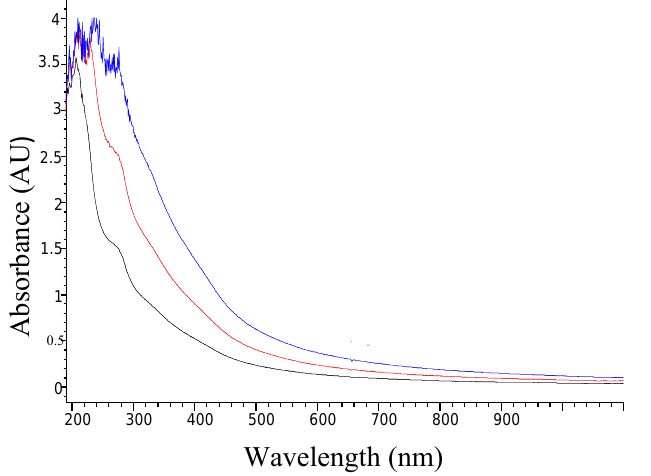
Figure 2. Absorbance UV-Visible spectrum of the photosensitizer mixed with PVA at three different concentrations, without dilution (blue), 50% diluted (red), and 75% diluted